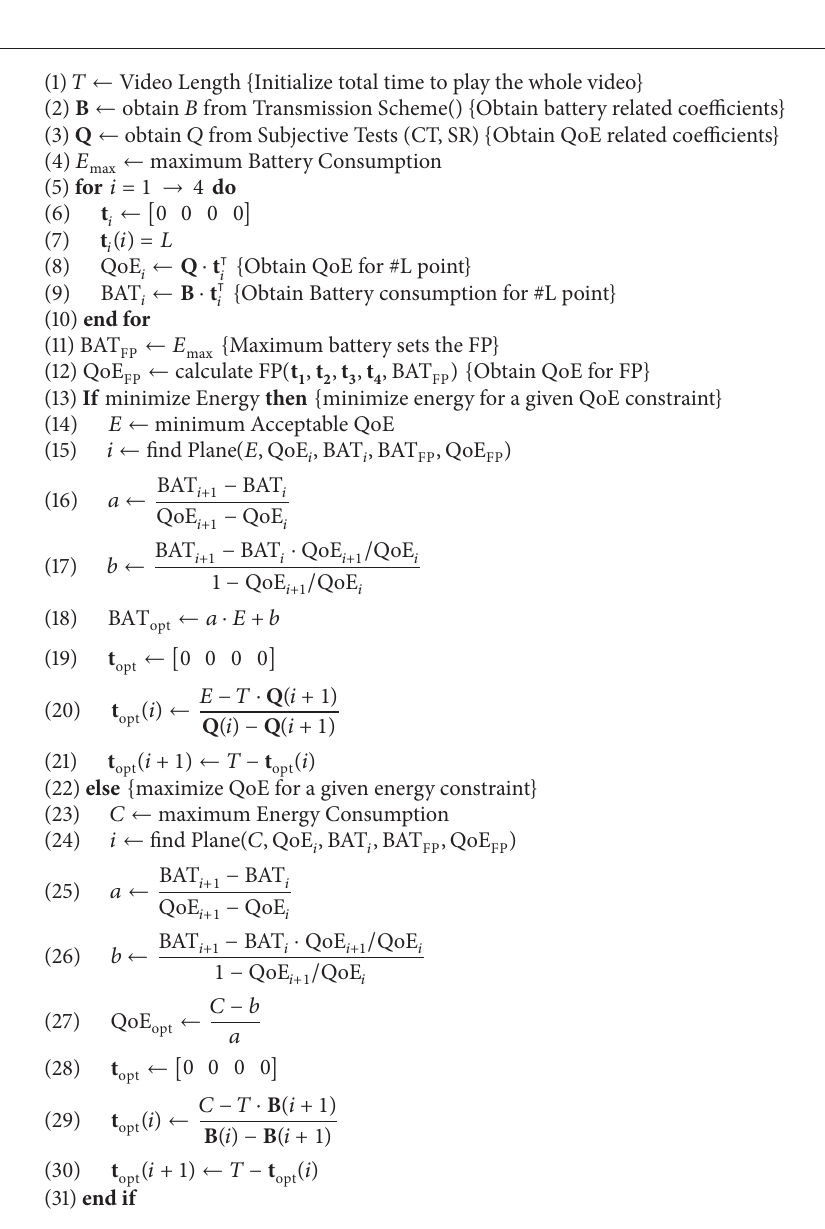
Algorithm 1: Heuristic for both SOLP optimization